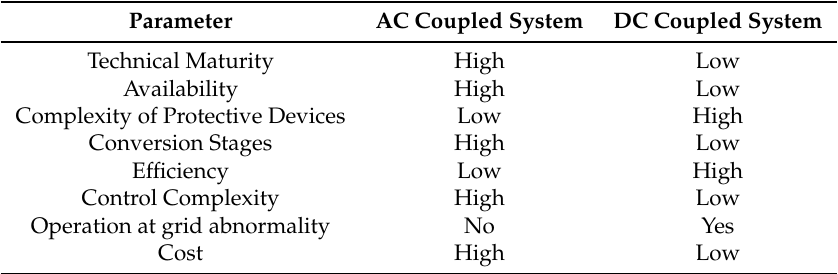
Table 4. Comparison between AC and DC coupled electric vehicle (EV) architecture.